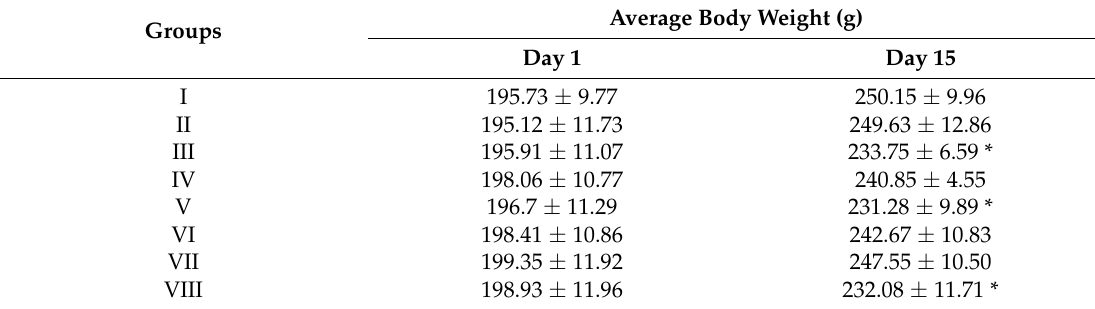
Table 2. Effect of repeated daily oral treatments with simvastatin, the crude lipophilic components and compounds in the average body weightof rats on day 1 and 15 before intraperitoneal injection of triton WR-1339.